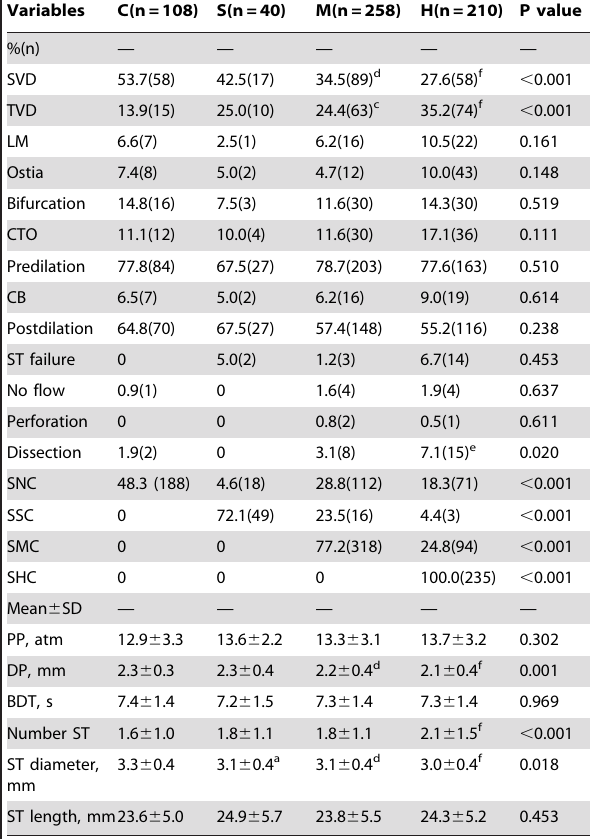
Table 2. Procedural characteristics among the four groups of subjects.